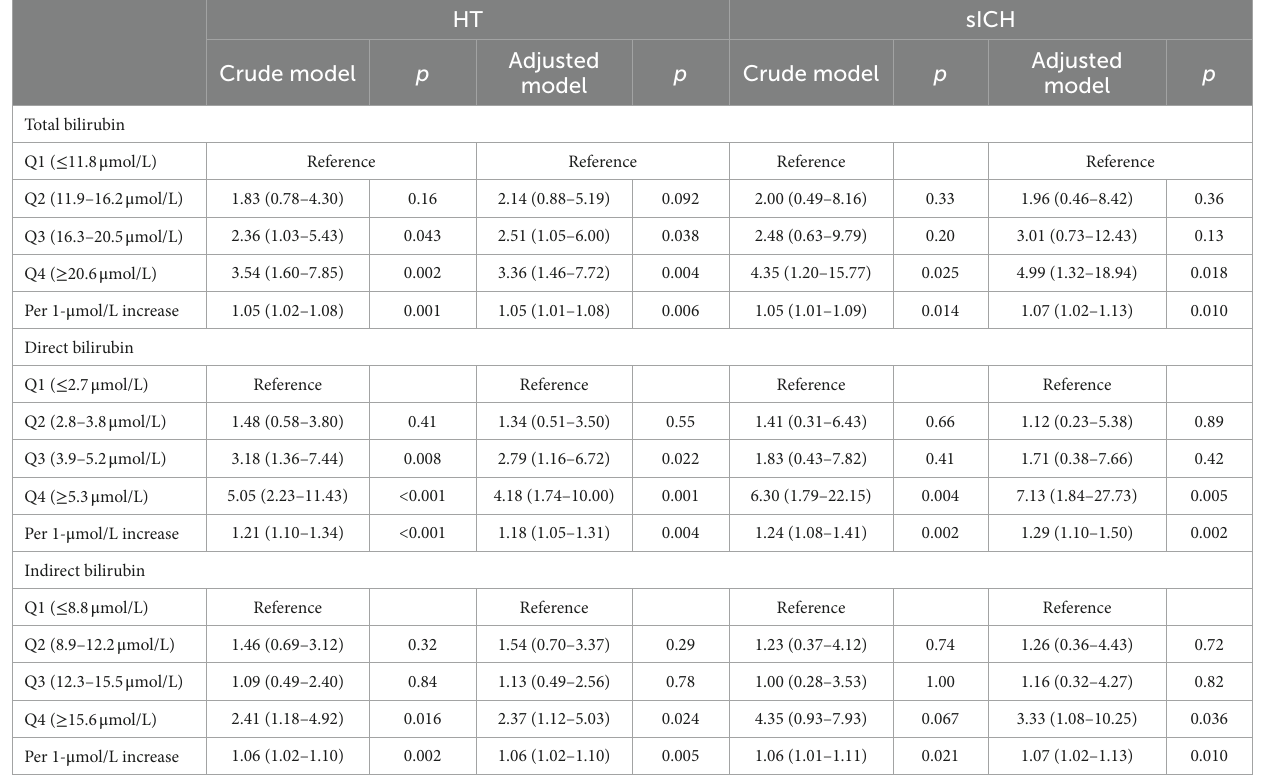
TABLE 3 Logistic regression analysis to identify associations of serum bilirubin with HT and